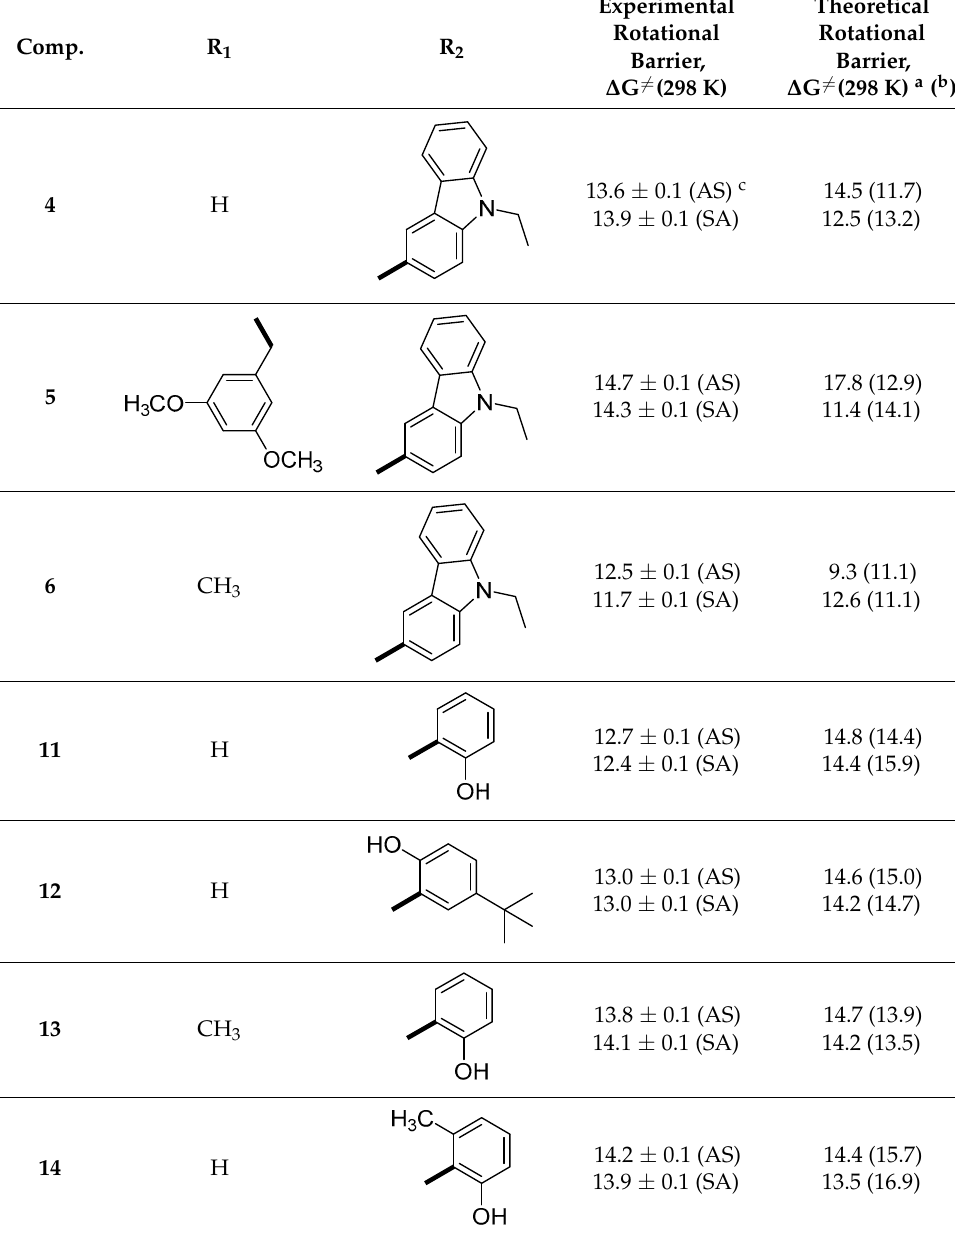
Table 3. Rotational barriers of propeller and asymmetric conformers in DMF-d7 of studied com- pounds. Comp.